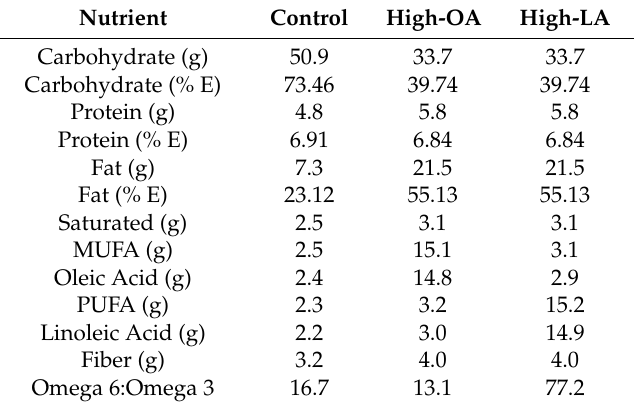
Table 1. Nutritional composition of experimental meals per 100